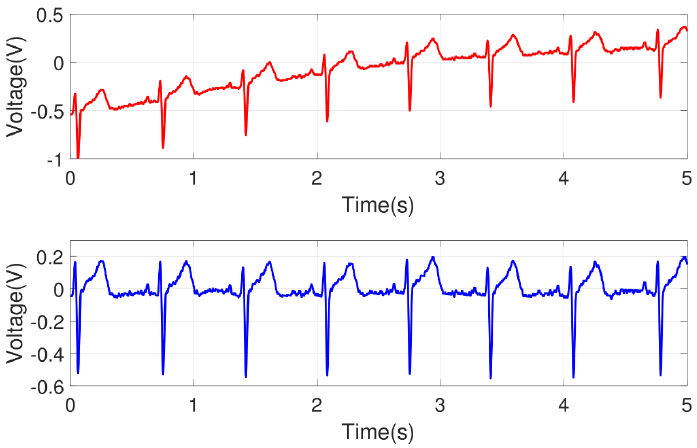
Fig. 1 Results of weight